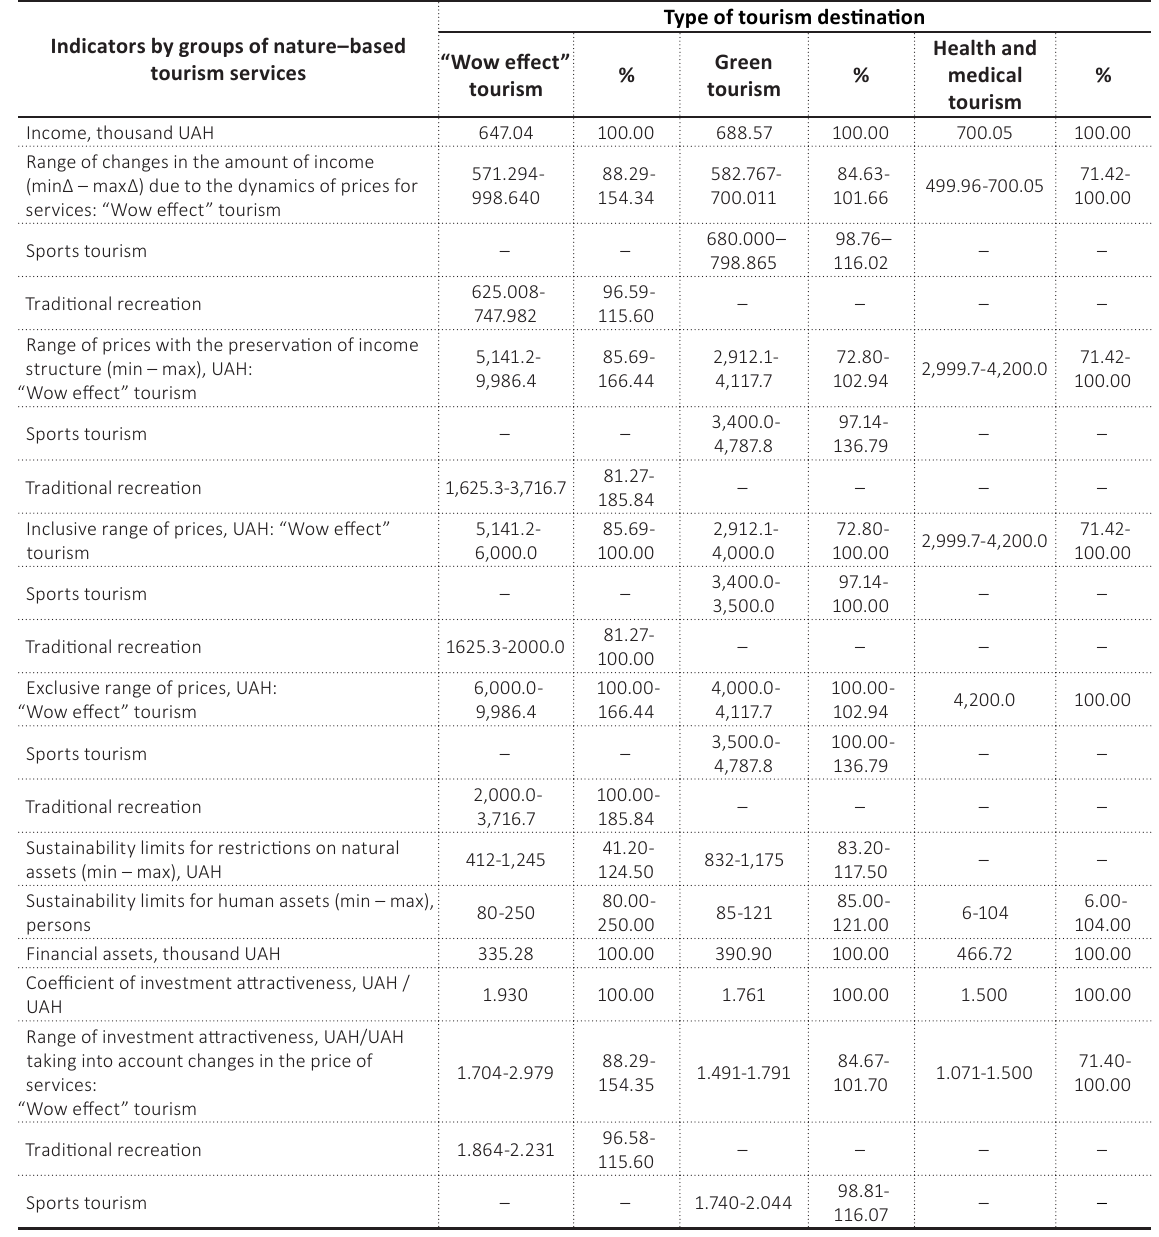
Table A11 (cont.). Generalized results of change management substantiation in the field of